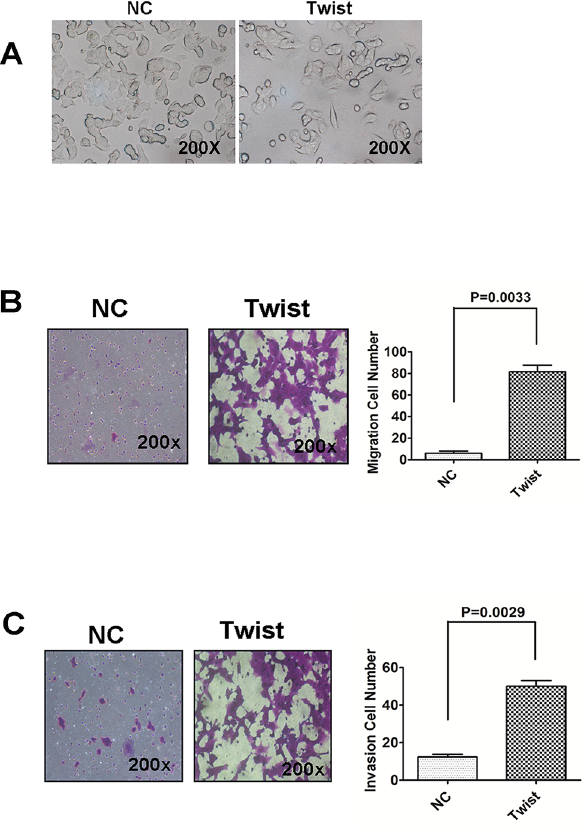
Fig 2. Overexpression of Twist promotes migration and invasion capability in MCF-7 cells. (A) MCF-7 cells overexpressing Twist displayed a more elongated spindle-like morphology and worse cell adhesion ability in comparison to MCF-7 cell stably transfected with pFlag-CMV as negative control. (B and C) Overexpression of Twist enhanced cell migratory and invasive capability. Empty vector and Twist-overexpressing MCF-7 cell were subjected to transwell migration and invasion assays (see Materials and Methods). Data shown are means ± SD of at least three independent experiments. P -values were obtained using the Student ’ s t-test